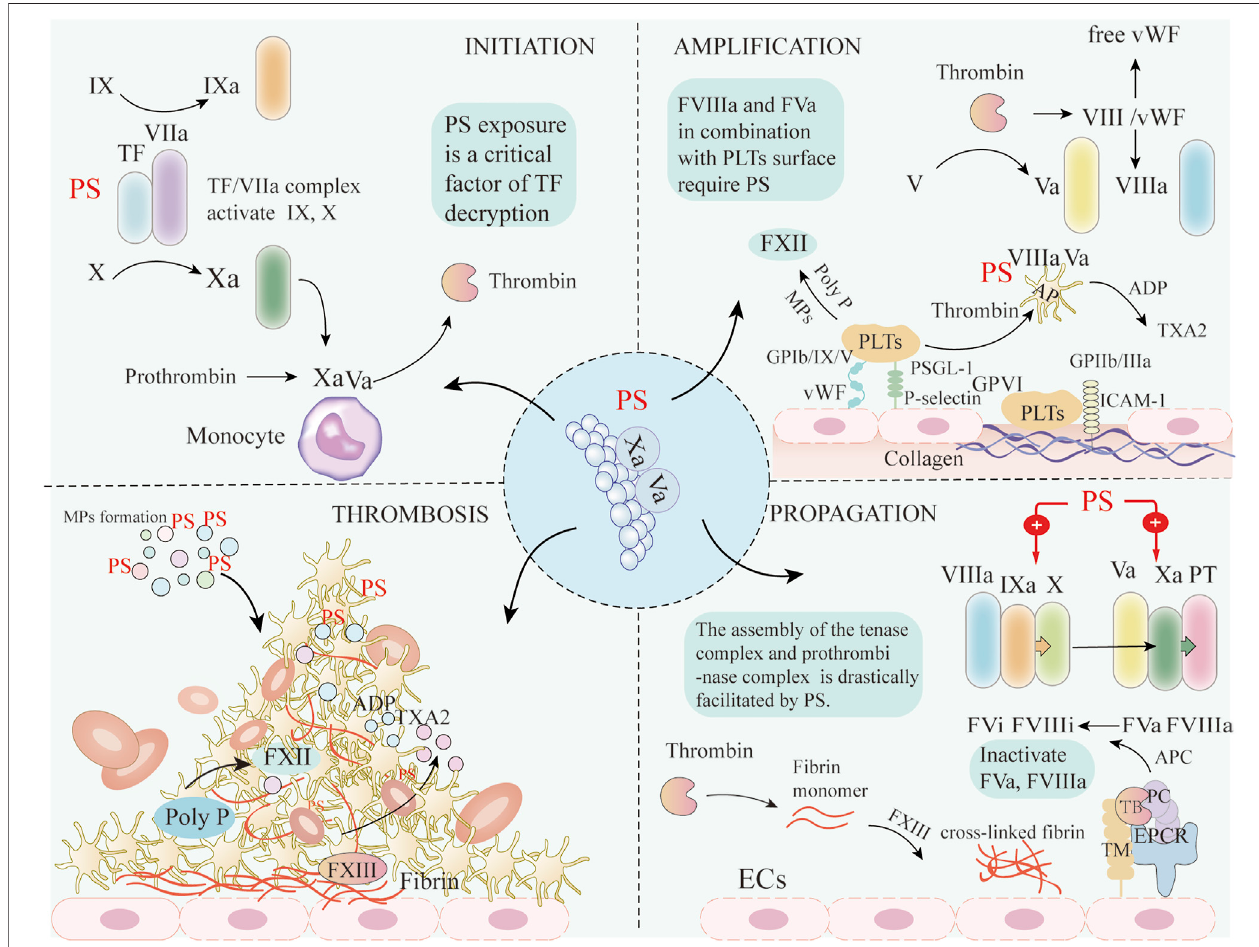
FIGURE3| ThemechanismsofPSinvolvedincoagulation.Duringtheinitiationstepofthecoagulationcascade,PSexposuremediatesTFdecryptioninitiatingthe extrinsic coagulation pathway. TF/FVIIa complex can then activate FIX and FX. Subsequently, FXa assembles with FVa on the surface of monocytes, and the prothrombinase complex generates thrombin by cleavage of prothrombin in blood plasma. During the ampli fi cation phase, thrombin activates circulating FV and FVIII, causingitsreleasefromvWF.Subsequently,FVIIIaandFVacombinewithPS-richphospholipidsontheactivatedPLTssurface.FollowingECsactivation,increased P-selectinandvWFexpressioninitiatePLTsadhesiontotheendotheliumthroughbindingwithPLTsPSGL-1andglycoproteinGPIb/IX/Vcomplex,respectively.ICAM-1 promotes PLTs adhesion via binding of fi brinogen with GPIIb/IIIa on the PLTs membrane. Moreover, exposed subendothelial collagen promotes PLTs adhesion and activation by binding to GPVI, eventually leading to PLTs aggregation. Activated PLTs release mediators, especially ADP and TXA2, which attract circulating platelets to thegrowingthrombus.PLTsactivateFXIIbyMPsformationandpolyPrelease,andincreasethegenerationof fi brin.Inthepropagationphase,exposedPSfacilitatesthe assembly of the tenase and prothrombinase complexes of the coagulation cascade. Thrombin cleaves soluble fi brinogen into fi brin and activates FXIII, which forms cross-linked and stable fi brin. The above coagulation processes ultimately lead to platelet activation and thrombus formation. ECs: Endothelial cells; PS: Phosphatidylserine; TF: Tissue factor; VIIa: Activated factor VII; Xa: Activated factor X; Va: Activated factor V; VIIIa: Activated factor VIII; PT: Prothrombin; TXA2: Thromboxane A2; ICAM-1: Intercellular adhesion molecule 1, PLTs: Platelets; AP: Activated platelets; vWF: von Willebrand factor; GP: Glycoprotein; Poly-P: polyphosphate; FXII: Factor XII; FXIII: Factor XIII; TB: Thrombin; PC: Protein C; APC: Activated protein C; TM: Thrombomodulin; ERCP: endothelial protein C receptor.